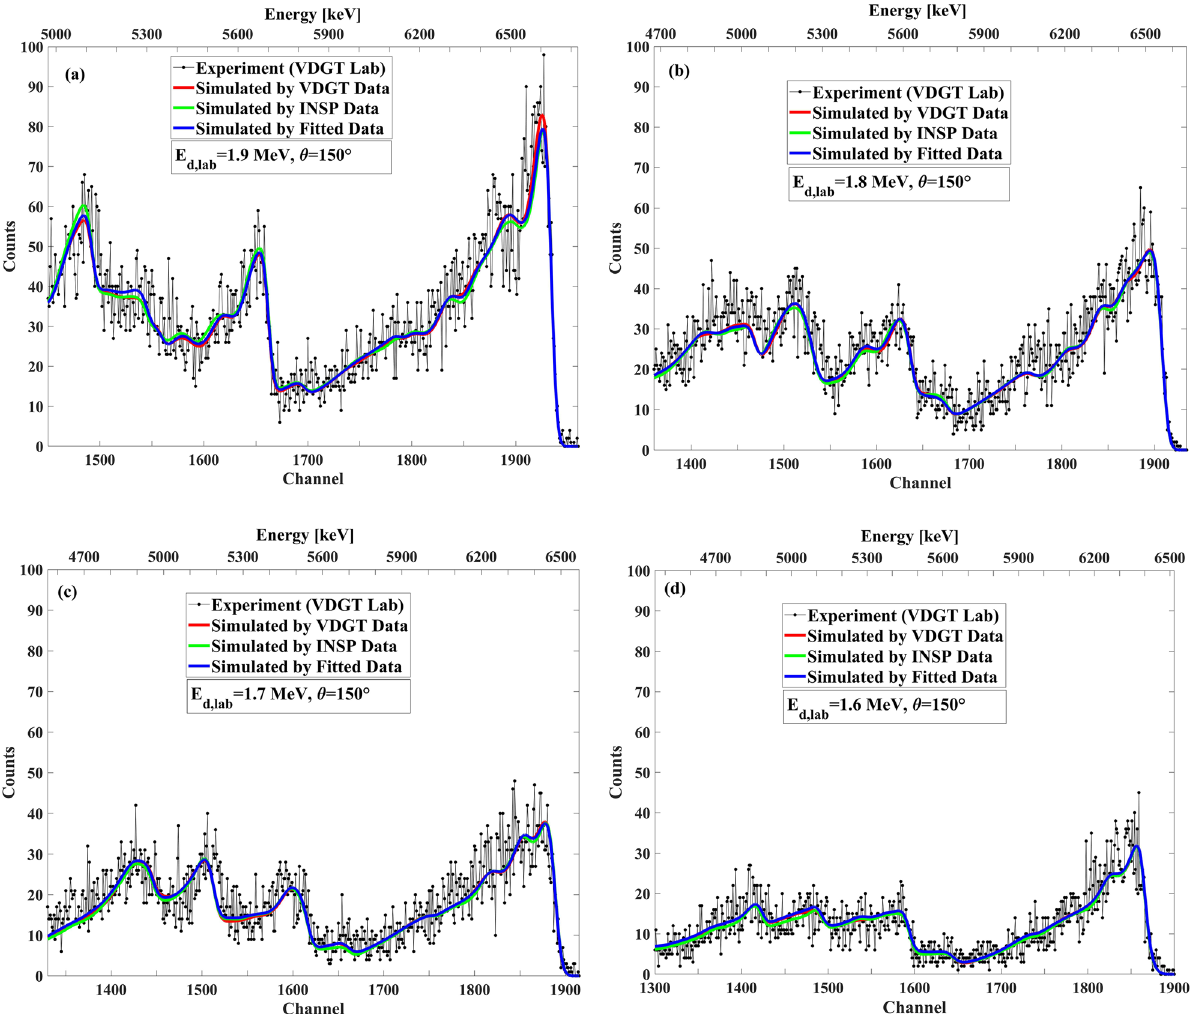
Figure 14. The benchmarking result at VDGT Lab in Tehran with different data sets at 150° and different incident deuteron energies, ( a ) 1.9 MeV, ( b ) 1.8 MeV, ( c ) 1.7 MeV and ( d ) 1.6 135°, respectively. The simulation at these angles employed the measured VDGT cross section data. In general, the correspondence between the simulations and the measured thick target spectra was very satisfying. The range of measured cross-sections used for simulating the spectra was 1.4–2 MeV. After energy loss in the Al target, whenever E d,Lab falls below the minimum energy of the measured cross section (1.4 MeV), the corresponding simulation of measured cross-sections has no value and SIMNRA considers its value equal to zero. In this case, for the 27 Al(d,p 0+1 ) reaction we manually inserted widely spaced cross section values for ener- gies below 1.4 MeV so that the measured thick target spectra in the energy range from 4700 to 5000 keV were reproduced by the simulations. Similar inclusions were made for the 27 Al(d,p 2+3 , p 4 , p 5+6 ) cross sections in the relevant energy ranges. These cross section values are certainly of the right amplitude, but because of the energy